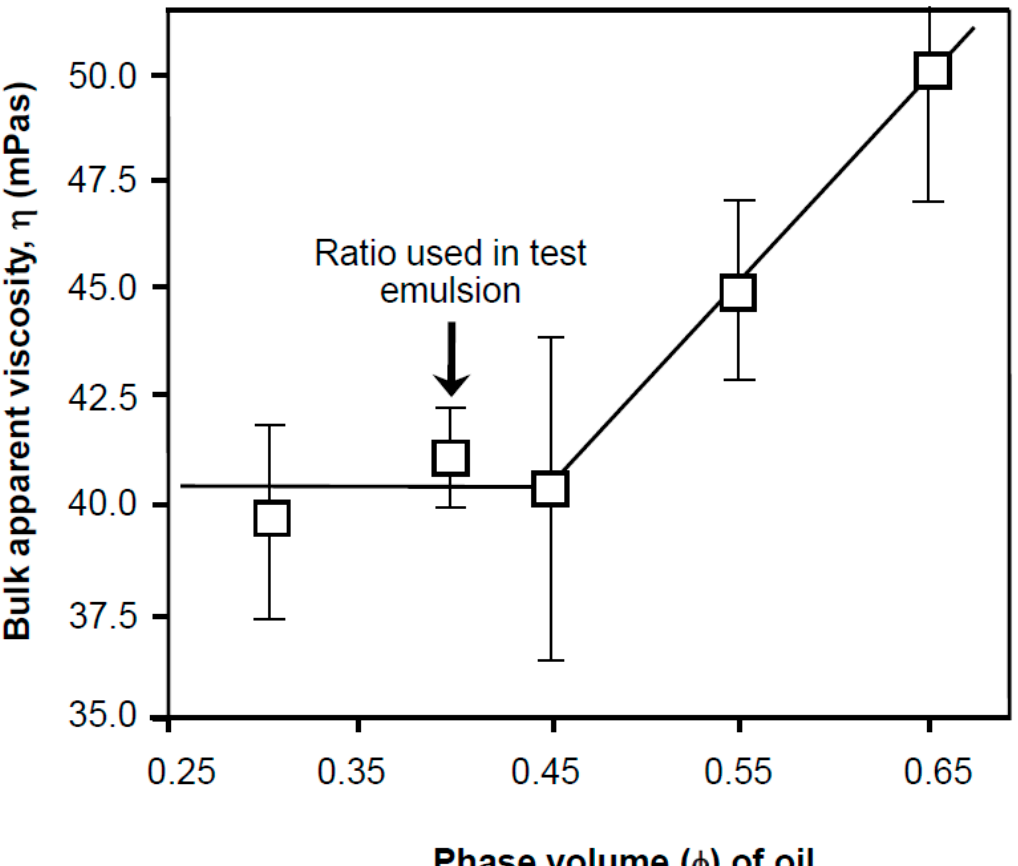
Figure 2. The consistency and texture as viscosity (averaged over a shear rate of 30–90/s) of the base emulsion made from 1 mM Tween 80 and liquid paraffin as the dispersed phase in water in the presence of 1 × 10 − 5 M sodium azide (lines merely represent an aid to the eye to show the trend in the data) as a function of the phase volume of the oil. All solutions used for samples were prepared from surface chemically pure 50 mM sodium phosphate buffered water, pH 7.0. Table 1. The average size of droplets in O/W batches of emulsions ( n = 3) formed from 1 mM Tween 80 solutions in the absence and presence of betamethasone phosphate (BMP) and fabricated at 25 °C in buffered media at pH 7.0.